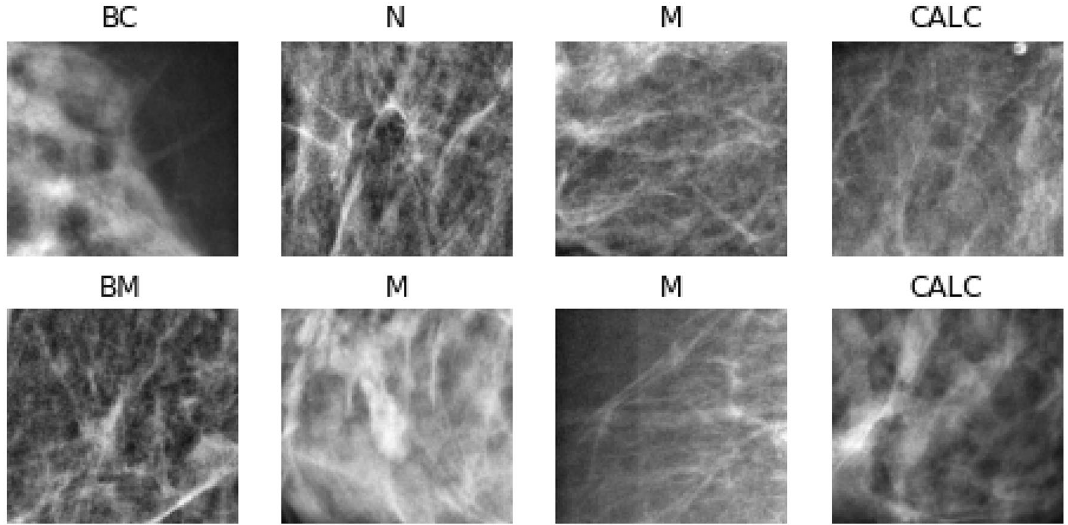
Figure 7. Samples of images with abnormalities as collected from the DDSM + CBIS and MIAS datasets with labels denoted as BC benign calcification, BM benign mass, CALC calcification, M mass.